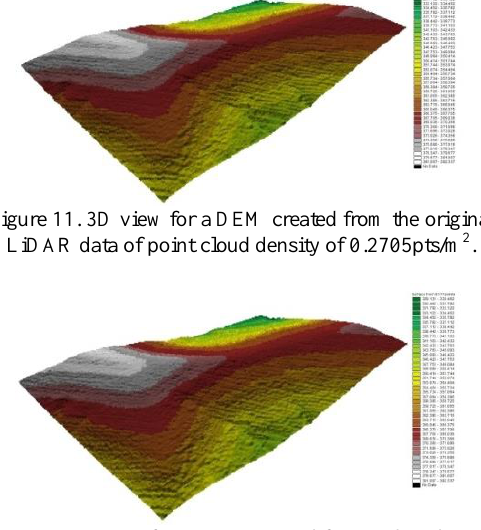
Figure 12. 3D view for a DEM created from reduced LiDAR data down to point cloud density of 0.222pts/m 2 .